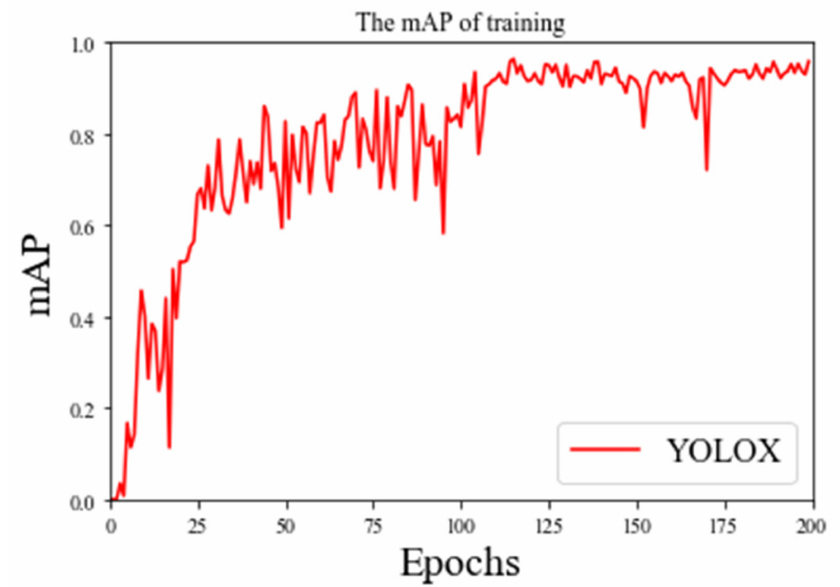
Figure 6. The mAP of